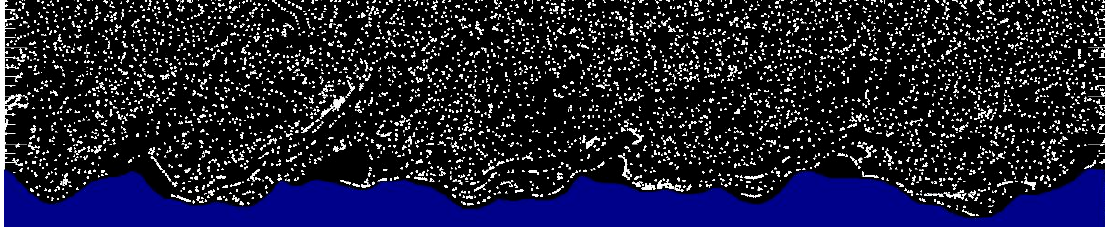
β Figure 1. Shape of as a function of nondimensional frequency uncertainty of approximation. 1—Snyder [29] (red color in the interval (0-2.5); 2—Plant [36]; 3— Hasselmann and Bösenberg [31]; 4—Donelan [32,33]; 5—Hsiao [30]; 6—Donelan [37]; 7—Chalikov,